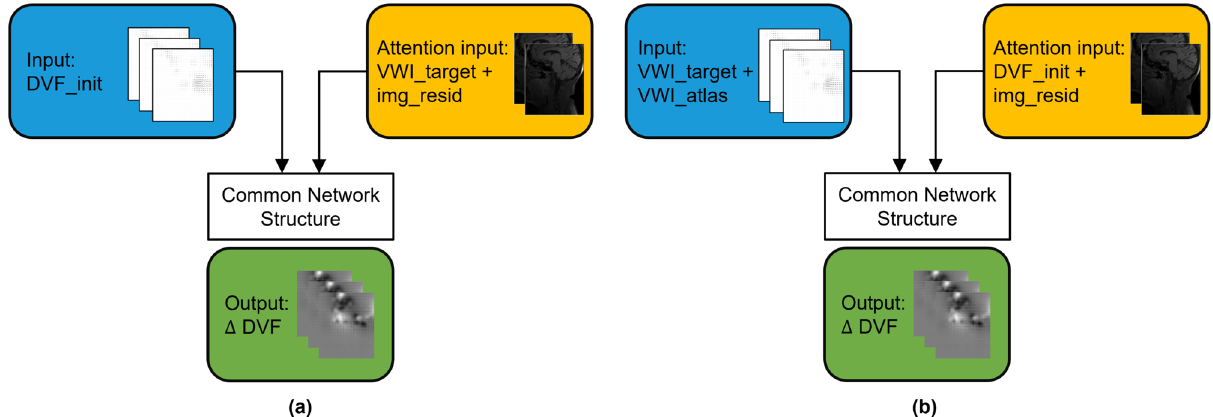
Figure 5. Two DVF refinement structures. ( a ) DVF2∆DVF with DVF input and images to drive attention; ( b ) Im2∆DVF with image input and DVF as well as residual error from stage 1 to drive